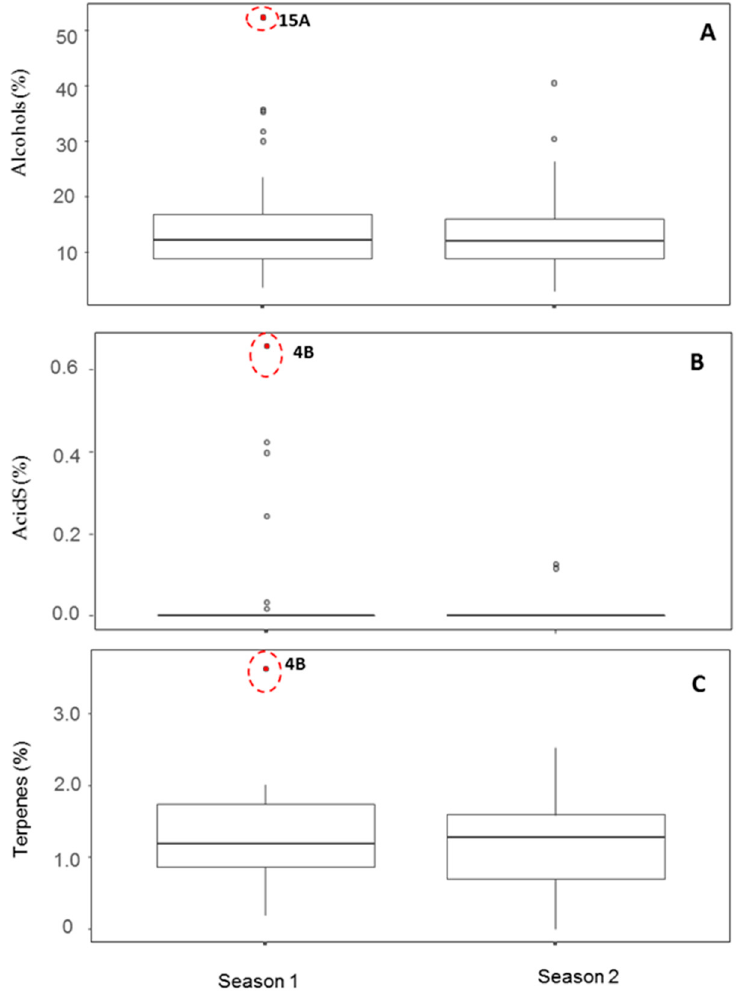
Figure 3. Box whisker-plot of three variables of compound classes (in percentage of area counts of the melon compound identified with match quality >50 and without exogenous compounds). ( A ) Alcohols; ( B ) acids; and ( C ) terpenes. Bold red circles indicate the selected outliers (with the fruit code beside this circle).